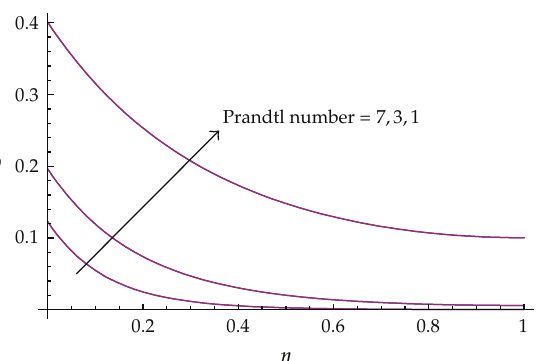
Figure 4: The behavior of the temperature distribution for various values of Pr with S (cid:7) 0 . 8, R (cid:7) 0 . 5, and B ∗ (cid:7) 0 . 5.